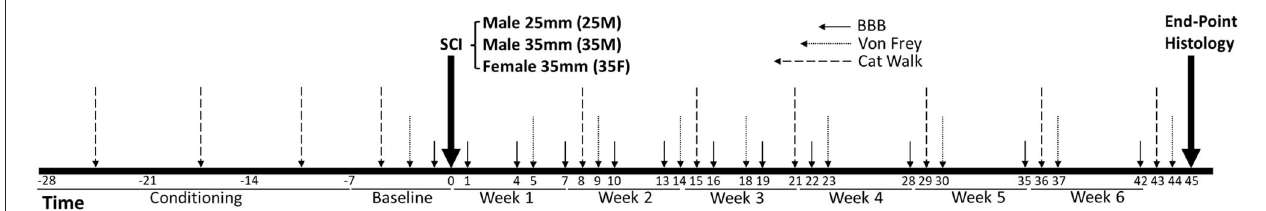
FIGURE 1 | Timeline of the experiment. Horizontal axes are in days, the day of the injury is recorded as day 0, post-injury dates are in positive numbers, pre-injury dates are in negative numbers. SCI, spinal cord injury; 25M, male 25-mm injury group; 35M, male 35-mm injury group; 35F, female 35-mm injury group. n = 6 for the 35M group, n = 8 for 25M and 35F